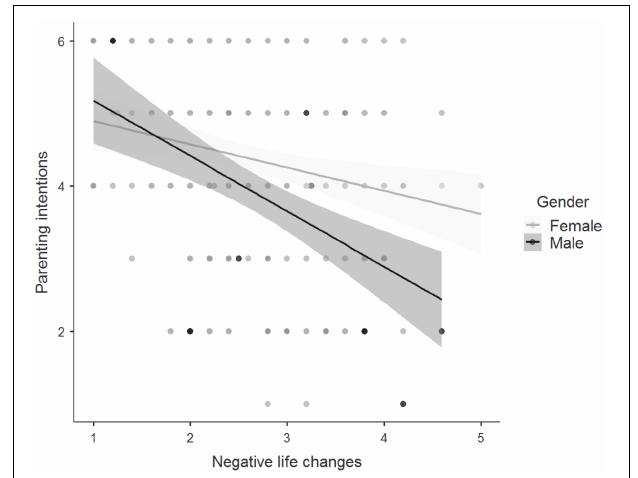
FIGURE 4 | Regression plot showing the relationship between perceived negative life changes in connection with becoming a parent and the strength of parenting intentions among men and women. Points represent individual responses, n = 269, and the gray shaded region represents the 95% confidence region. For perceived negative life changes, responses were on 5-point Likert scale with higher scores indicating more negative expectations of future parenthood. For the strength of parenting intentions, responses were on 6-point Likert scale with higher scores indicating a stronger intent to become a parent.